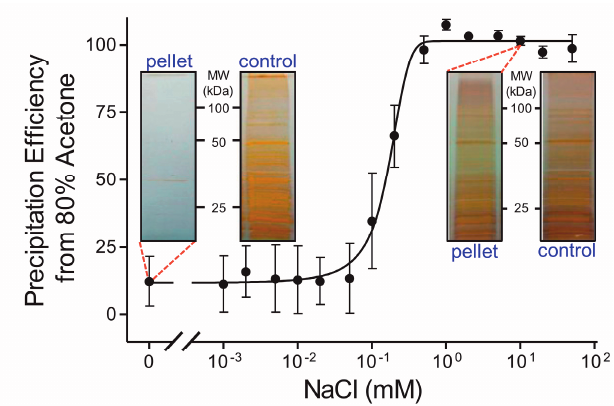
Figure 1. Acetone precipitation efficiency varies with salt concentration. The protein yield from an acetone precipitation in a complex mixture correlates with protein concentration, dielectric strength of the solution, and intrinsic protein charge. The overall model proposed is an ion-pairing model for organic solvents. With this protocol, efficiencies of 100% can be achieved for acetone precipitation. Figure adapted from Crowell, et al. (2013)